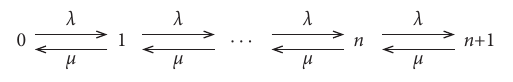
Figure 2: The transition rate diagram of observable